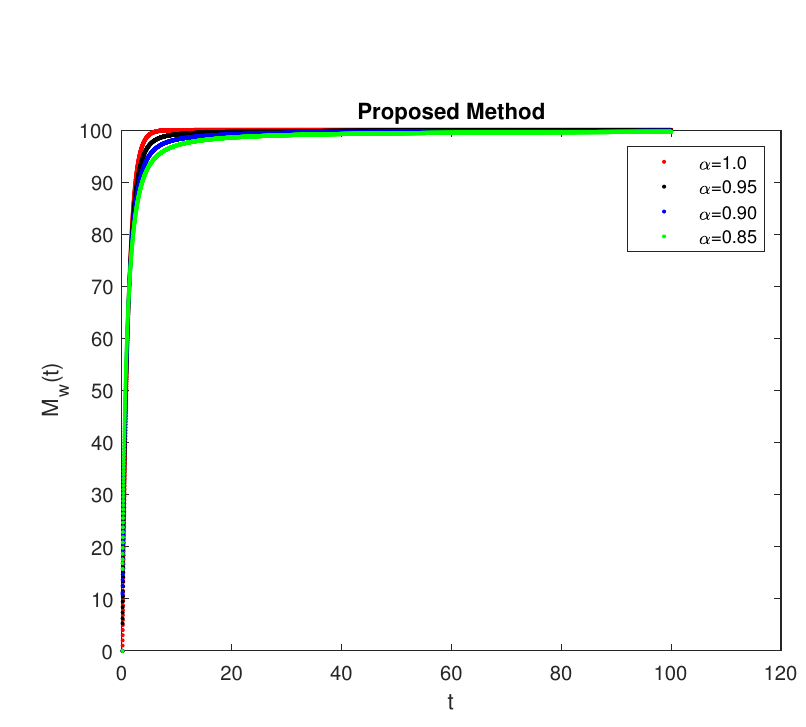
Figure 6: Numerical simulations for τ = 0.98 for ABC